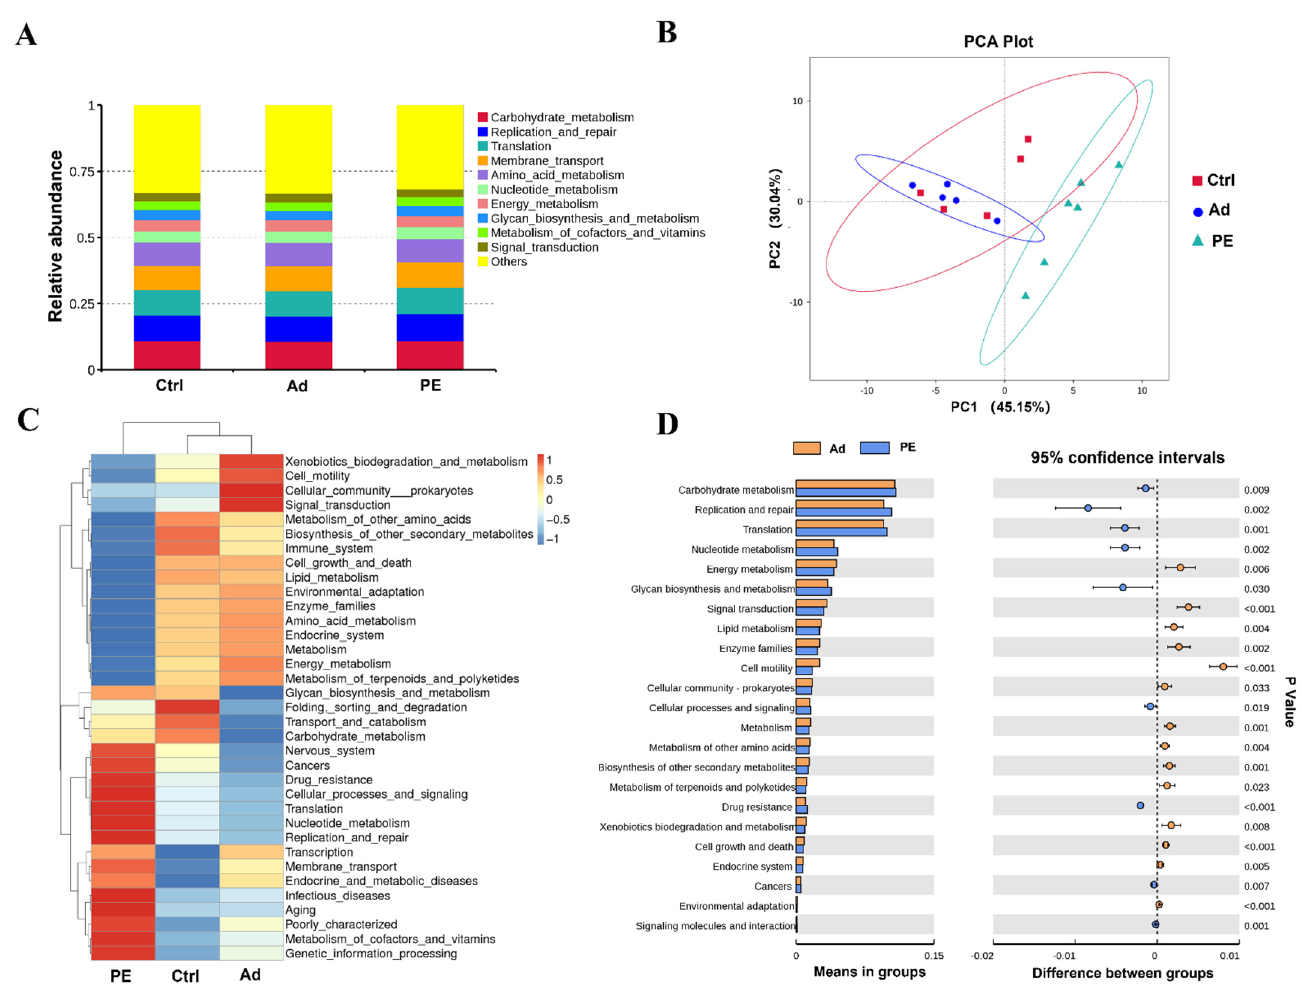
Figure 8. Predicted functions of gut microbiota were analyzed by the Tax4Fun analysis ( n = 6 for PE group; n = 5 for Ad and Ctrl groups). ( A ) Relative abundance of genes in functional pathways on level 2. ( B ) PCA analysis on level 2. ( C ) Heatmap of functional pathways on level 2. ( D ) The signif- icant functional pathways between the PE and Ad groups on level 2. Each dot represented one sam-